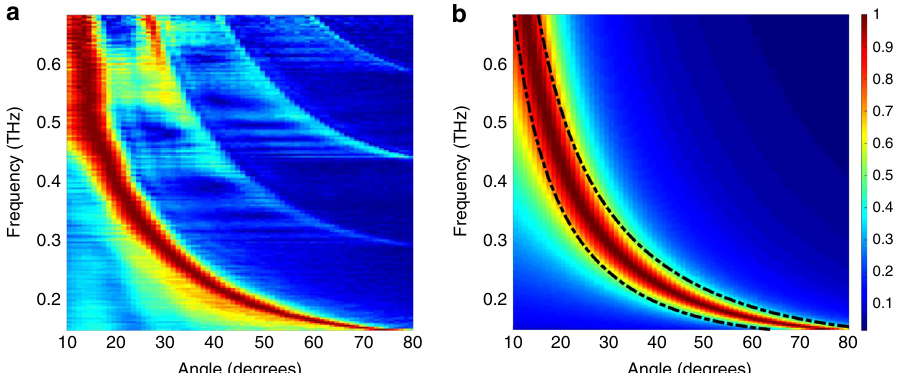
Fig. 2 The spectrum of emitted radiation vs. emission angle. a A plot of the spectrum of the radiation emitted by a LWG at emission angle ϕ 0 (de fi ned in Fig. 1b), after excitation with a broadband input. This is measured using a broadband detector staring directly at the emission point, without a second LWG. Each row of this image has been normalized to unity magnitude, in order to remove the frequency-dependence of the input signal from the THz-TDS transmitter, and emphasize the signals at higher frequency. The prominent arc in the lower left region corresponds to the emission from the dominant TE 1 waveguide mode; the weaker arcs in the upper right arise from higher-order TE waveguide modes (TE 2 , TE 3 , and TE 4 ), which result from imperfect input coupling to the waveguide. The TE 1 mode signal represents about 90% of the total radiated energy. b Two different predictions of the measured spectrum- angle relation displayed in a . The false color plot corresponds to a diffraction model (Eq. 2) using a value of α = 0.213 mm − 1 for the leakage parameter, while the two dotted black curves represent the results of a ray optics model (Eq. 3), with the numerical parameter values discussed in Supplementary Note